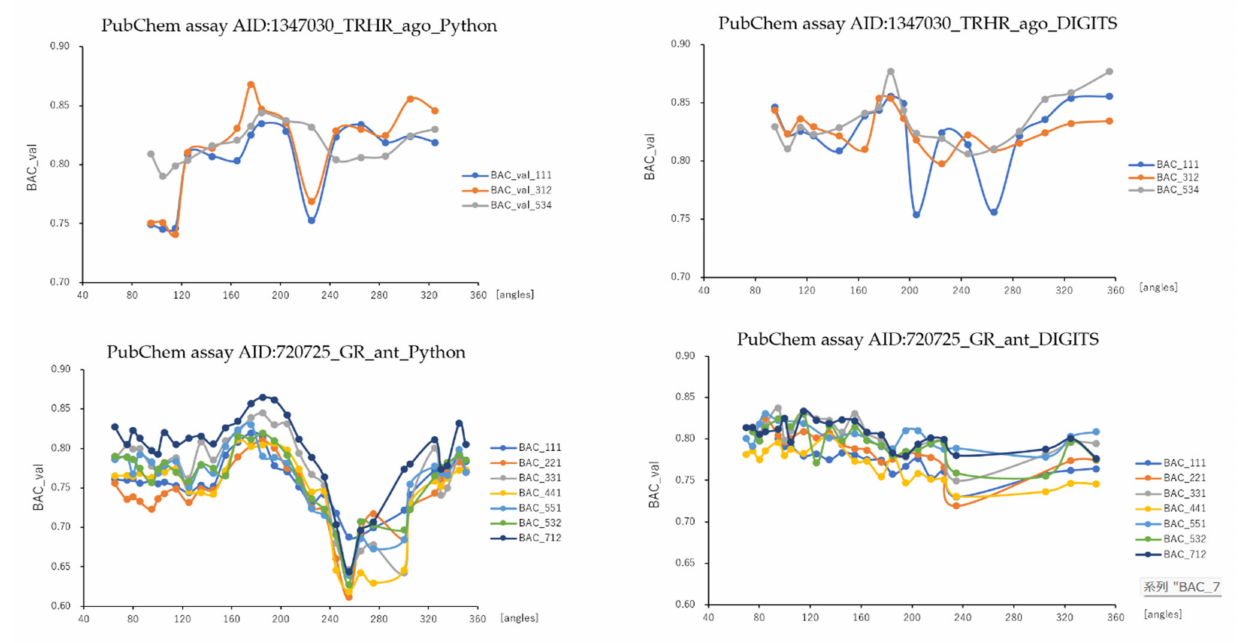
Figure 2. Differences in mean ROC_AUC levels shown as dots with 95% confident interval (95% CI) as error bars with angles in DeepSnap-DL using TensorFlow and DIGITS of prediction models of the glucocorticoid receptor (PubChem assay AID:720725_GR_ant), TGF-beta/Smad (PubChem assay AID:1347032_TGF_beta_ant), and agonist of the thyrotropin-releasing hormone receptor (PubChem assay AID:1347030_TRHR_ago) in the validation dataset; n = 3.